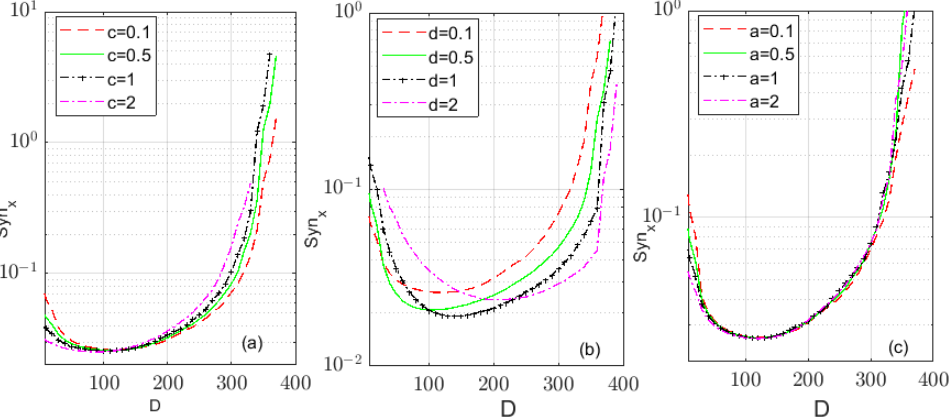
Figure 13. The average position synchronization error Syn x curves of noise intensity D with different a ( a ) , c ( b ) , and d ( c ).